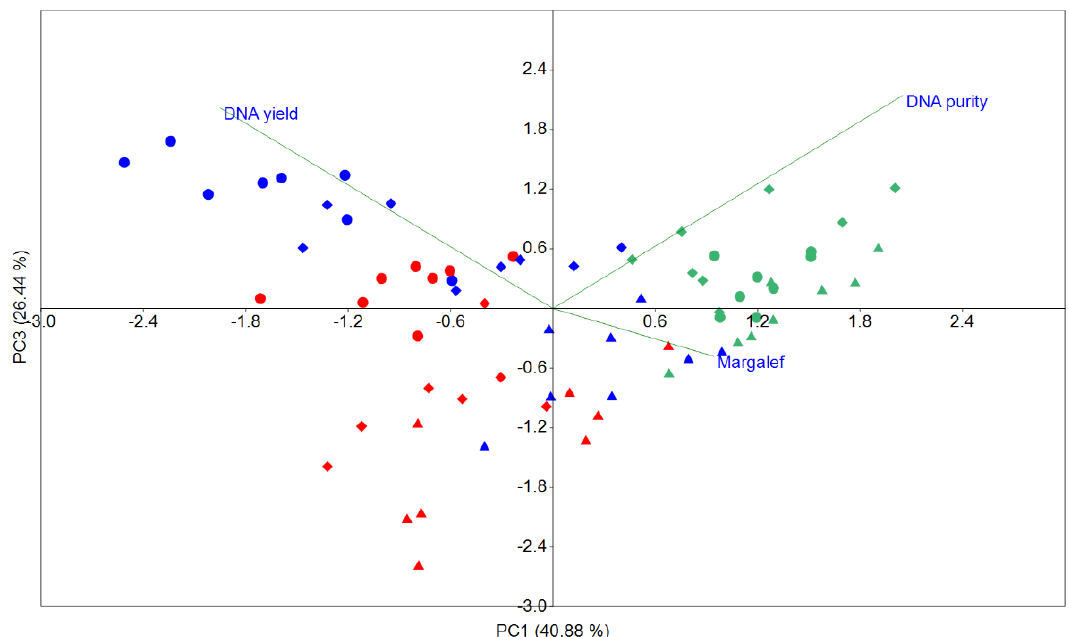
Figure 3. PCA biplot (scores and loadings) presenting the correlations between DNA obtained from different types of biomass and the different kits used. Dots—activated sludge, diamonds—biofilm, and triangles—anaerobic digestate. Blue color—FASTD, red color—PUREL, and green